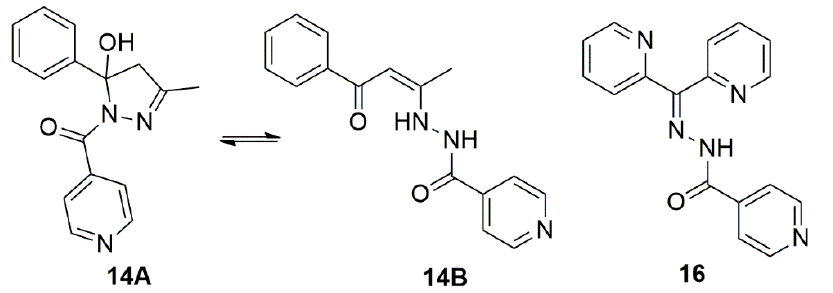
Figure 1. Molecular structures of the compound 14 in (A) cyclic form and (B) open chain form and compound 16 .